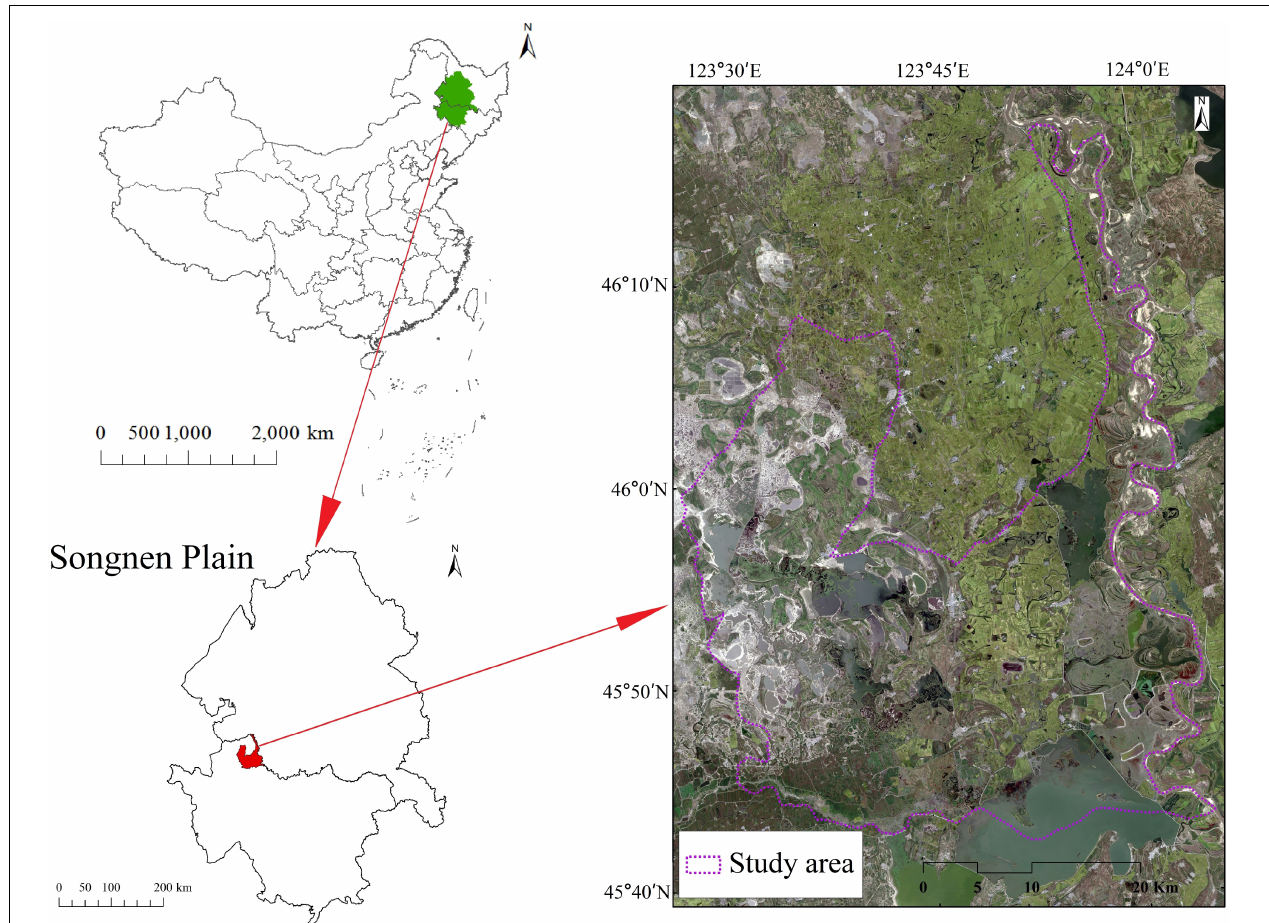
FIGURE 1 | Location of the study